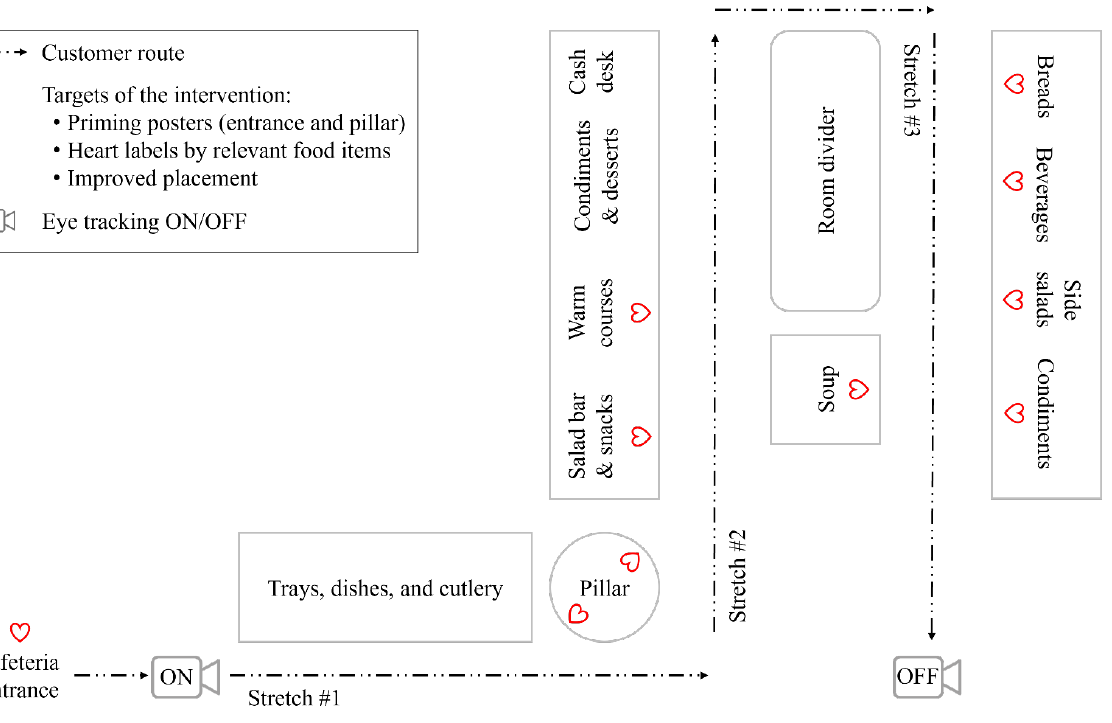
Figure 1. A schematic floor plan of the cafeteria serving line.